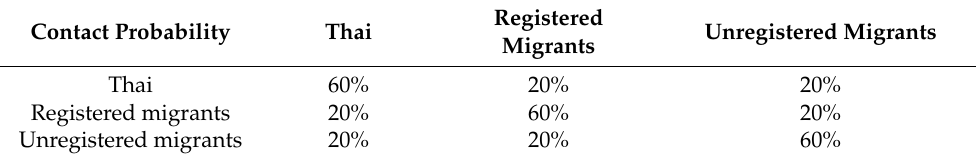
Table 1. Probability of contact for each population